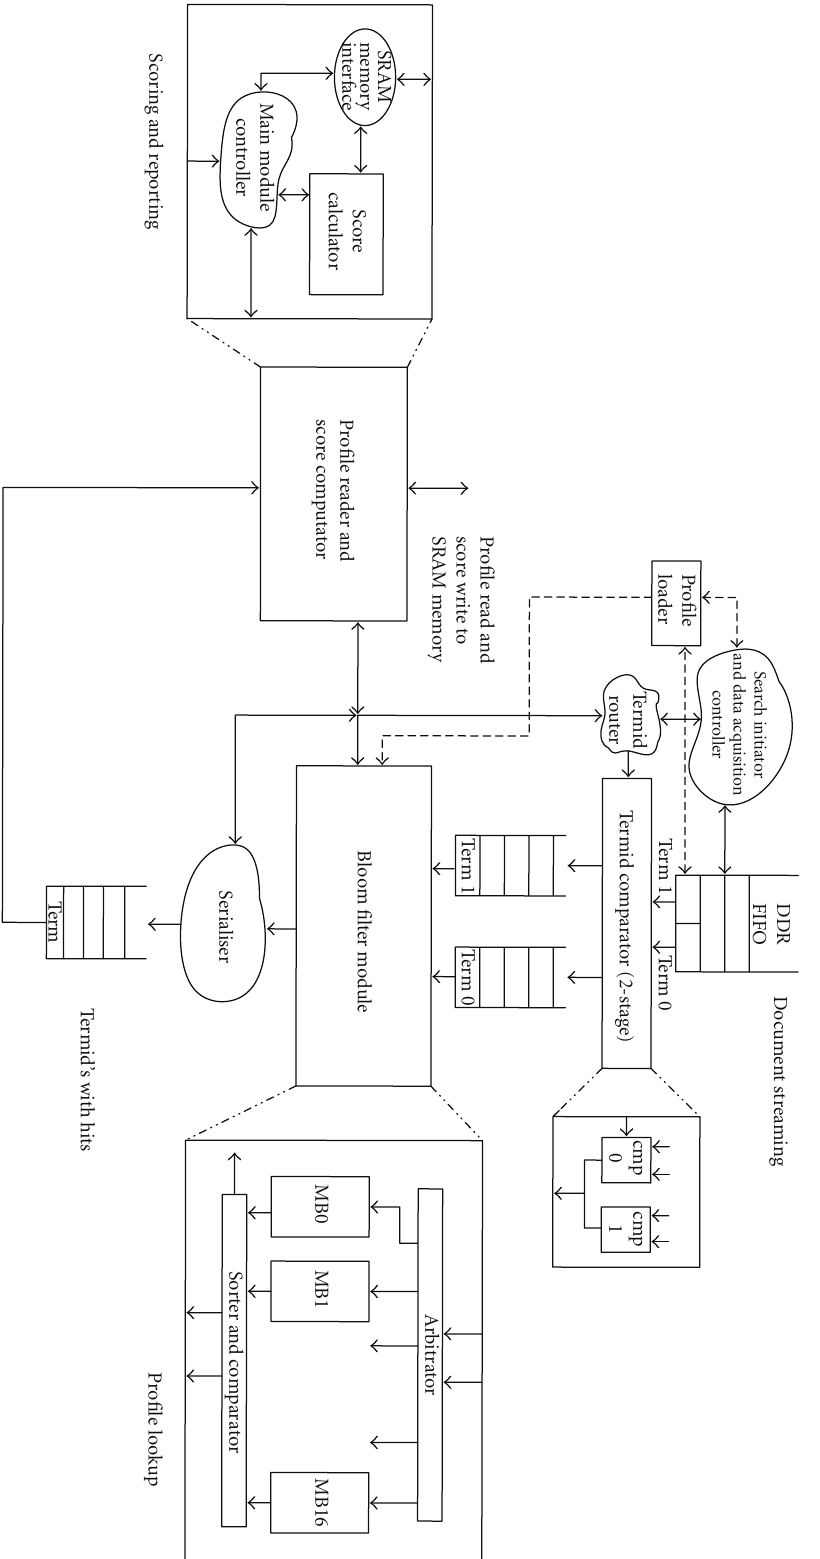
Figure 12: Overall block diagram of FPGA